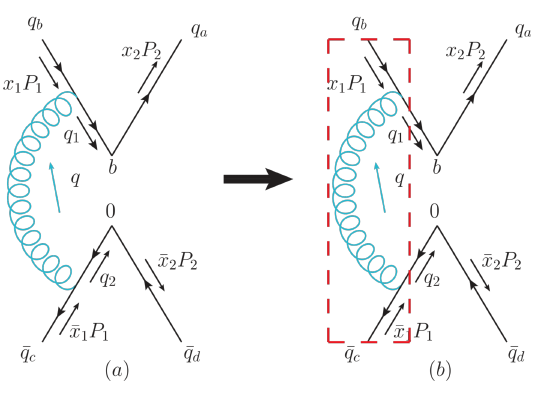
Figure 6 . Factorization of form factor shown in figure 5(a). Only collinear mode contributes in this diagram, while both hard and soft contributions are power suppressed.